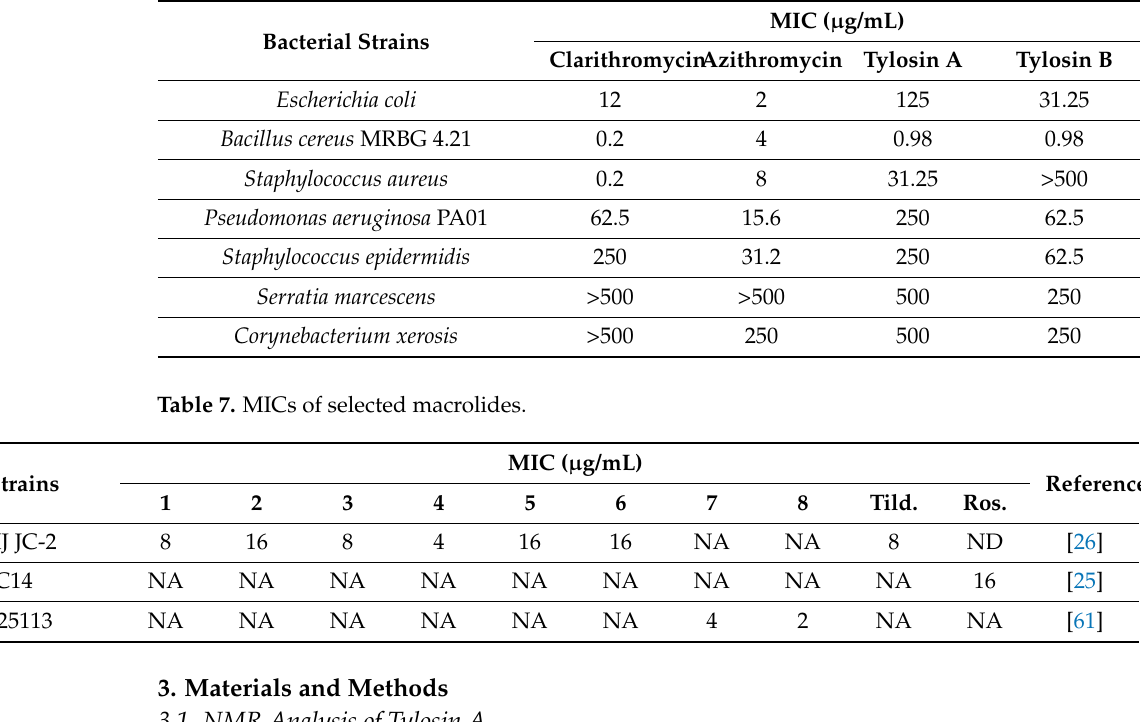
Table 6. Minimum inhibitory concentrations (MICs) expressed in µ g/mL for tylosin A and tylosin B compared to clarithromycin and azithromycin.